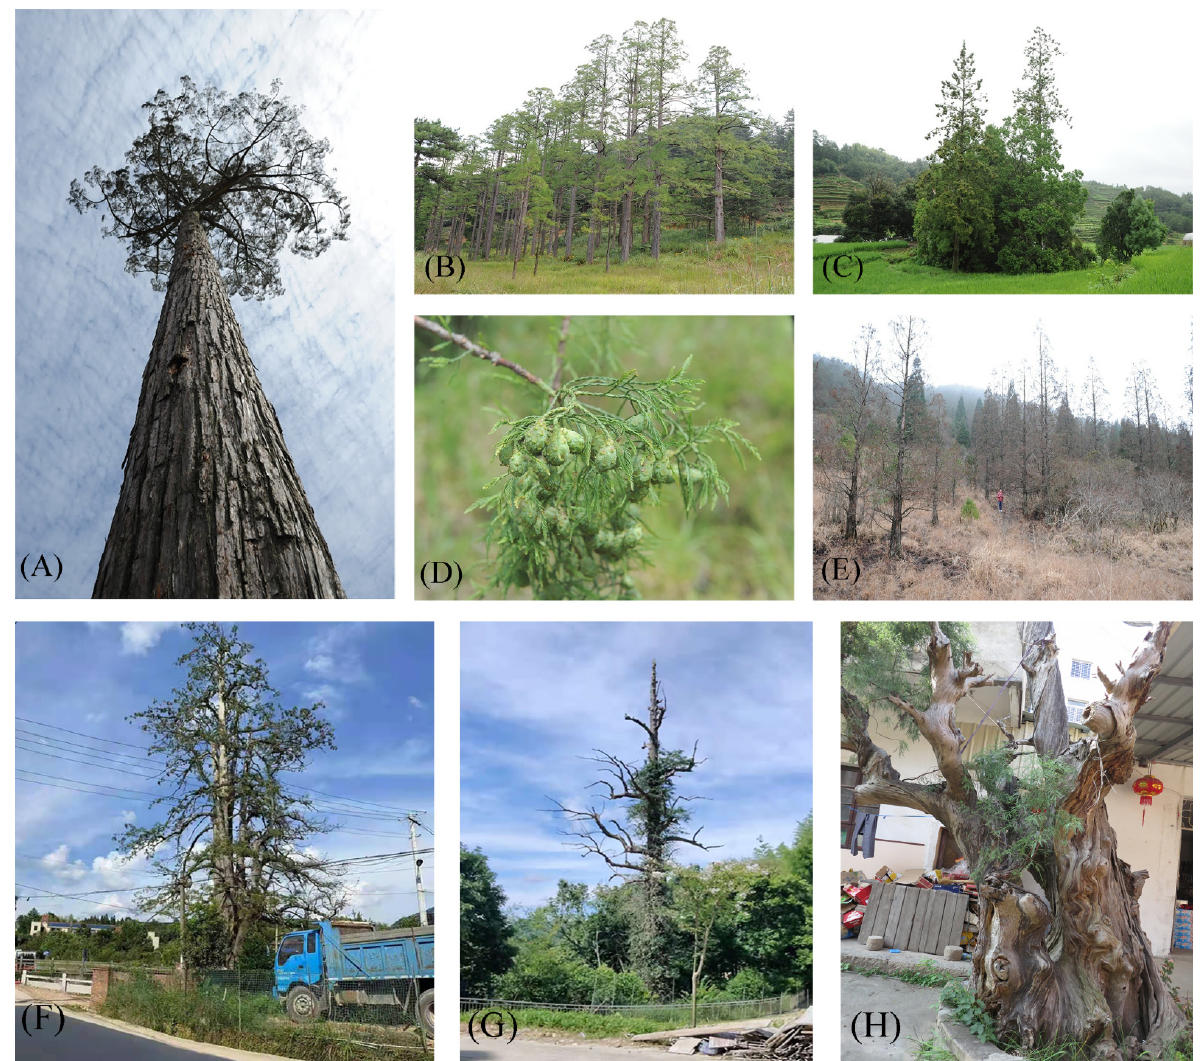
Figure 1. Photos of Glyptostrobus pensilis in the field. ( A ) A G. pensilis tree in Gutian county, Fujian Province; ( B ) community of G. pensilis in Pingnan county, Fujian Province; ( C ) community of G. pensilis in Fu’an City, Fujian Province; ( D ) strobile of G. pensilis ; ( E ) community of G. pensilis in Youxi county, Fujian Province; ( F ) Zhangping City, Fujian province: ( G ) Datian County, Fujian Province; ( H ) Fuqing city, Fujian Province. Photos ( A – C , E ) were taken by Shi-qun Zheng; ( D , F , G ) were taken by Xing-zhuang Ye; ( H ) was taken by Bao Liu.